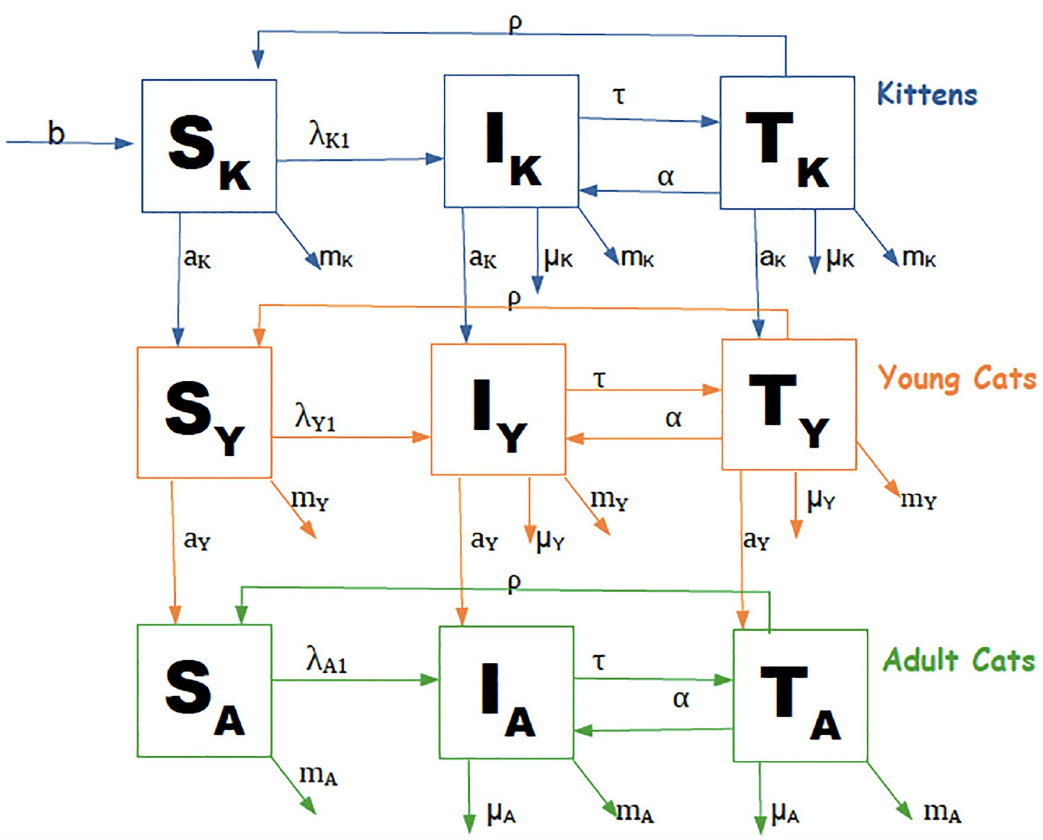
Fig 1. Diagram of the transmission model of feline sporotrichosis. Compartment structure is the same for both sexes.